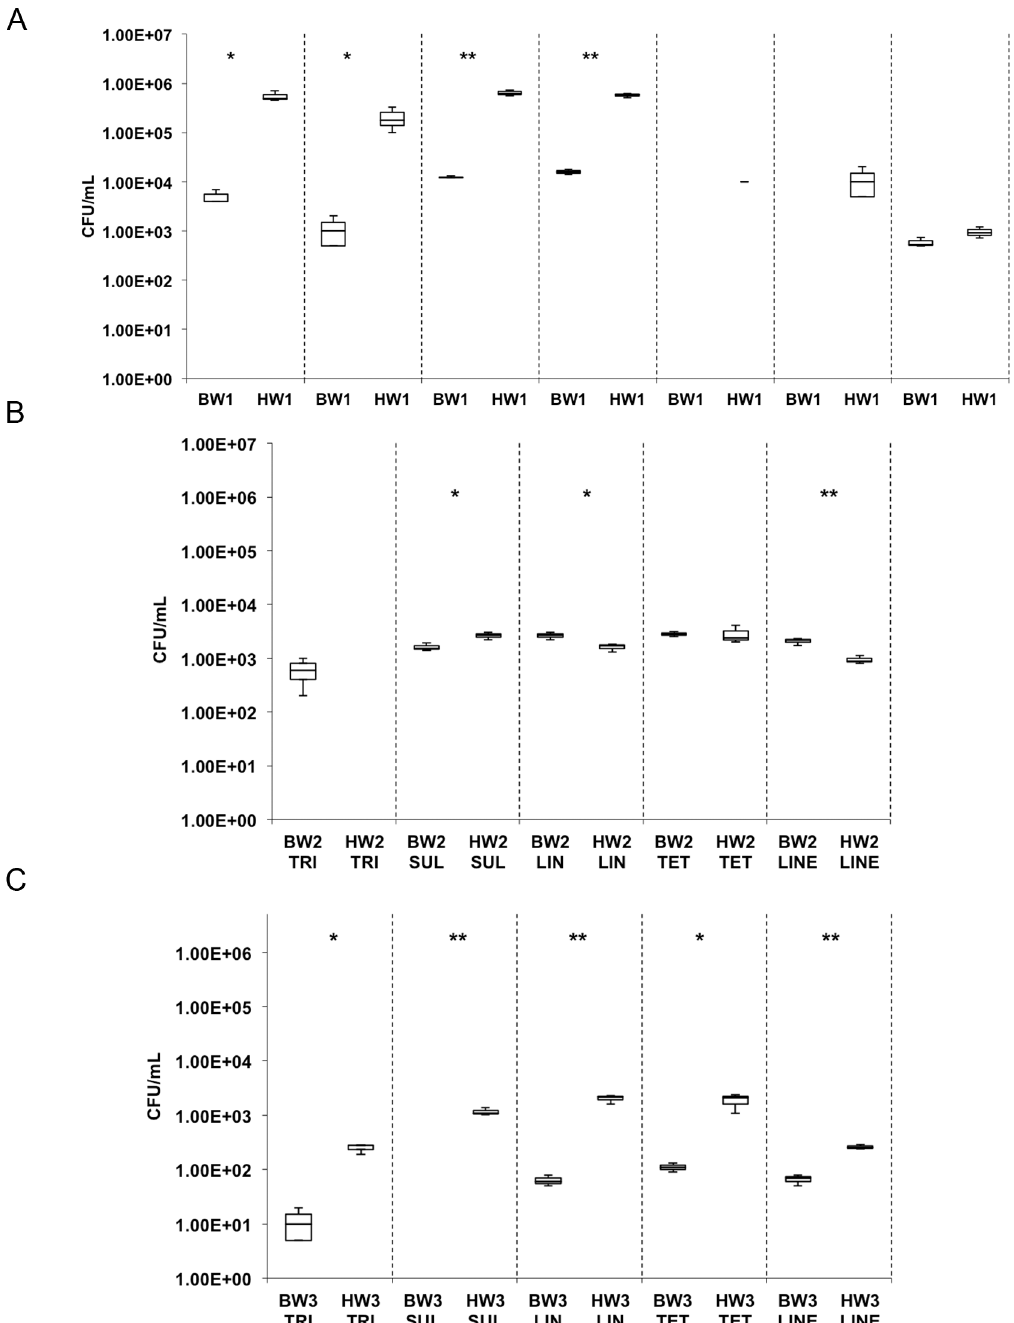
Fig 4. The concentrations of heterotrophic bacteria and their resistance to 8 antibiotics in ballast and harbor waters (A) BW1 and HW1, (B) BW2 and HW2, (C) BW3 and HW3. TRI: Trimethoprim; SUL: Sulfanilamide; NOR: Norfloxacin; LIN: Lincomycin; TET: Tetracycline; ERY: Erythromycin; KAN: Kanamycin; LINE: Linezolid. Two-tailed T-test, * P < 0.05, ** P < 0.01.